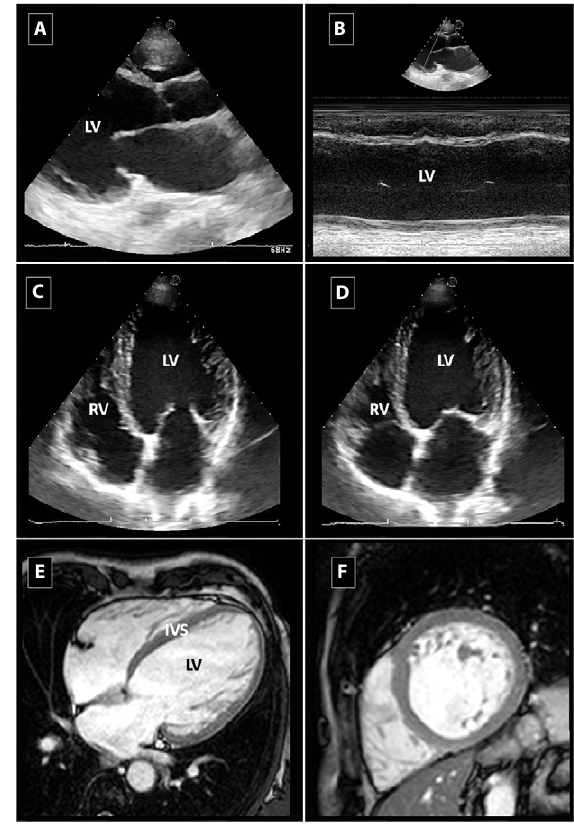
Figure 4. Dilated cardiomyopathy. Echocardiographic and cardiac magnetic resonance images from a 57-year old female patient with DCM and normal coronary angiogram. Parasternal long axis view and CMR images show dilated LV (panels A–B and E–F), with severe systolic dysfunction - EF = 21%; (panel C = diastole, panel D = systole). Abbreviations: LV = left ventricle, RV = right ventricle IVS = inter-ventricular